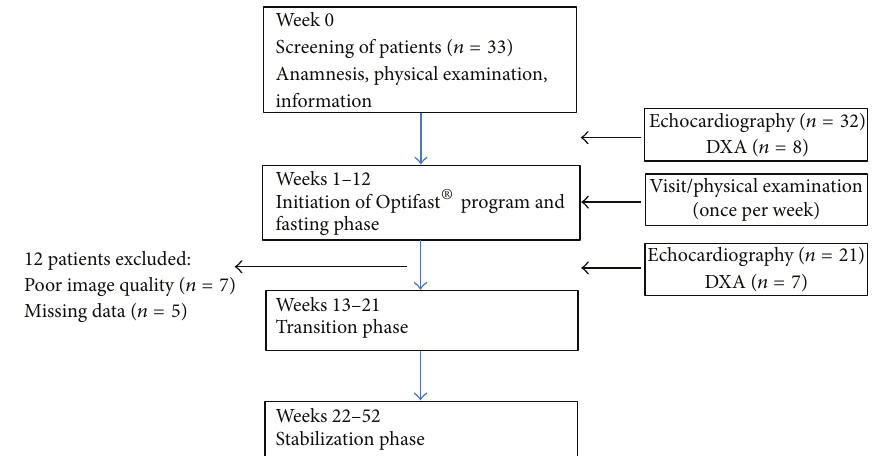
Figure 1: Study flow diagram. DXA: dual energy X-ray